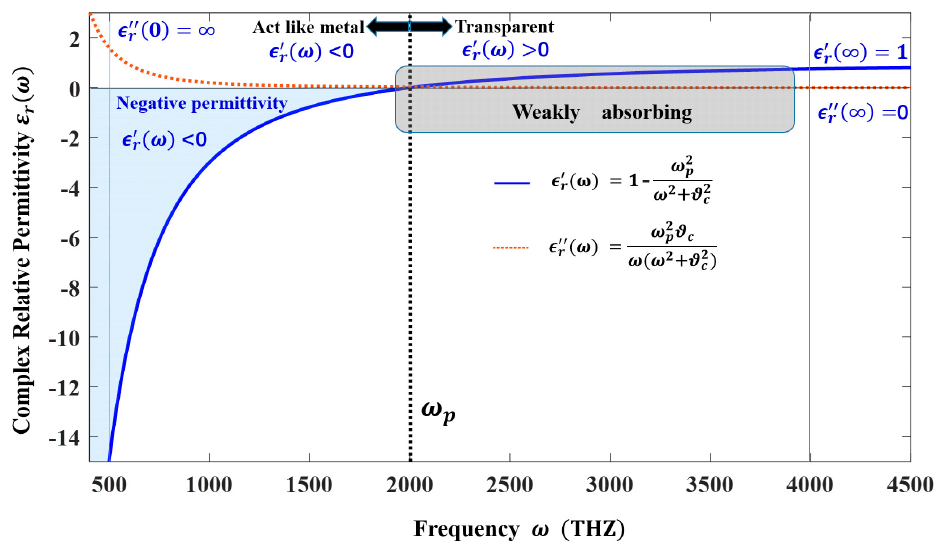
Figure 3. Complex relative permittivity of plasma in frequency domain.